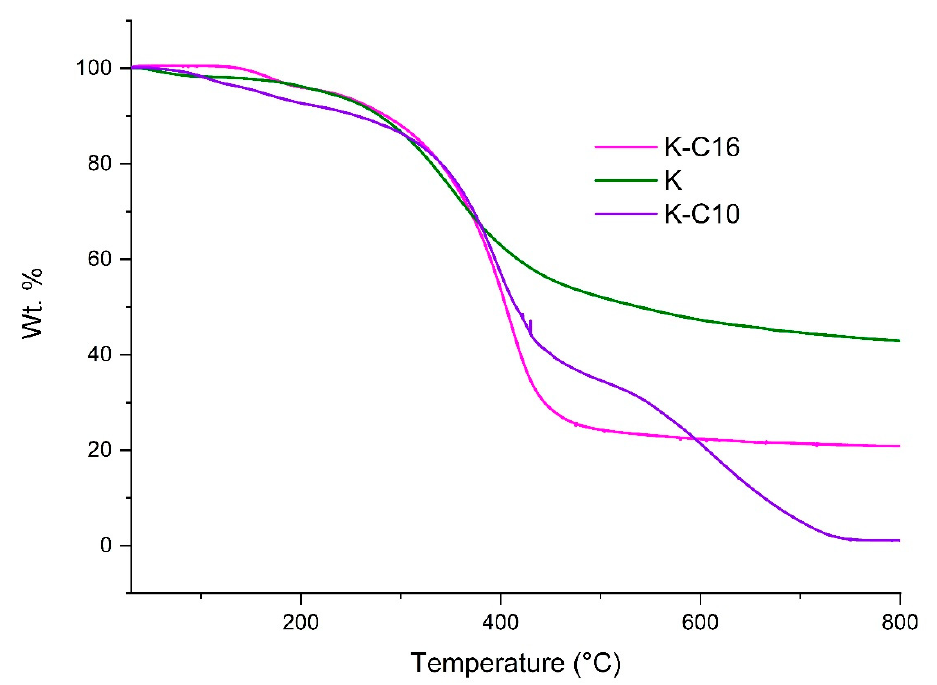
Figure 6. Thermal decomposition graphs obtained under nitrogen atmosphere of nonfunctionalized and etherified Kraft lignin.